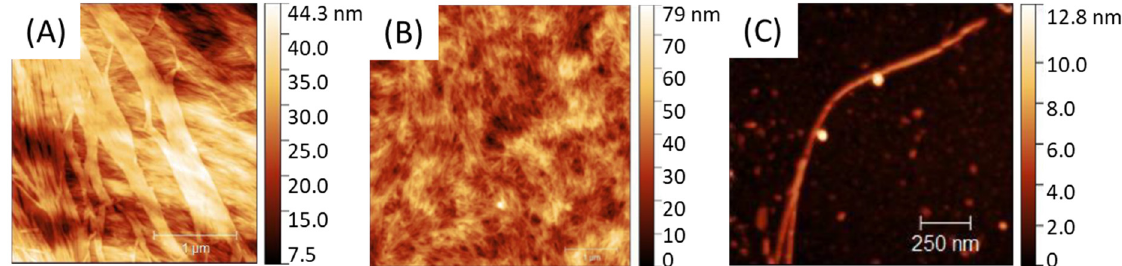
Figure 2. AFM of C 16 V 3 A 3 K 3 G-NH 2 self-assemblies from different PA concentrations: [PA A ] = 20 mg · mL − 1 ; [PA B ] = 5 mg · mL − 1 ; [PA C ] = 0.05 mg · mL − 1 .